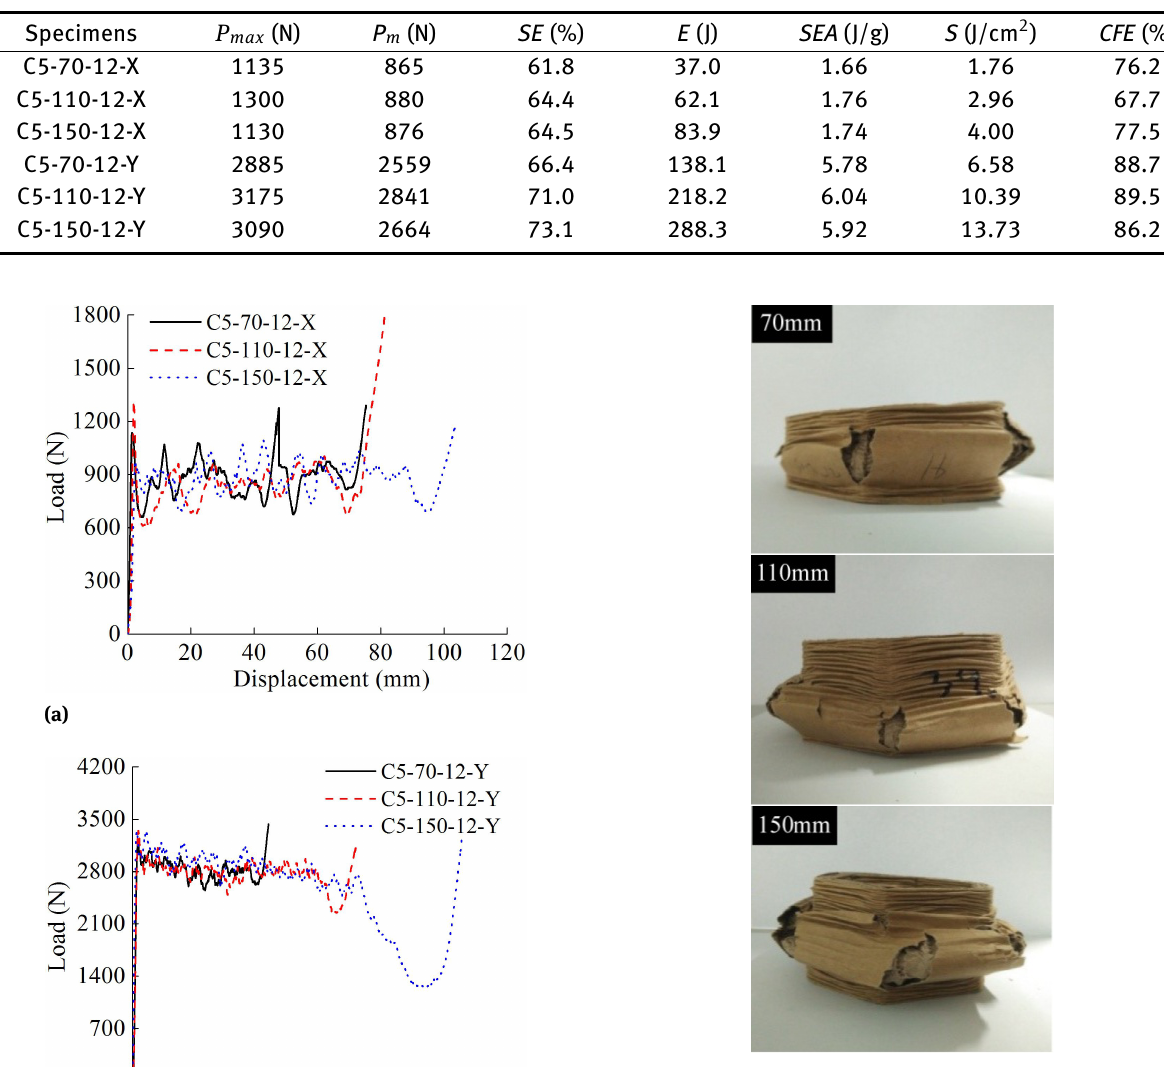
Table 4: Cushioning energy absorption of regular pentagon paper corrugation tubes